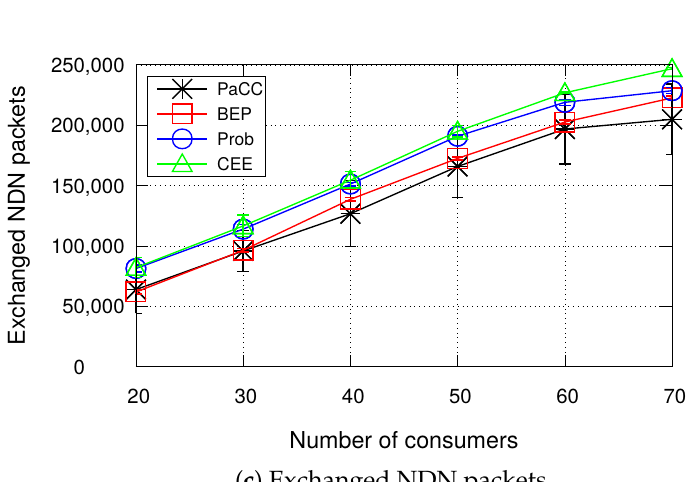
Figure 9. Metrics when varying the number of consumers (cache size equal to 0.5% of the cata- logue